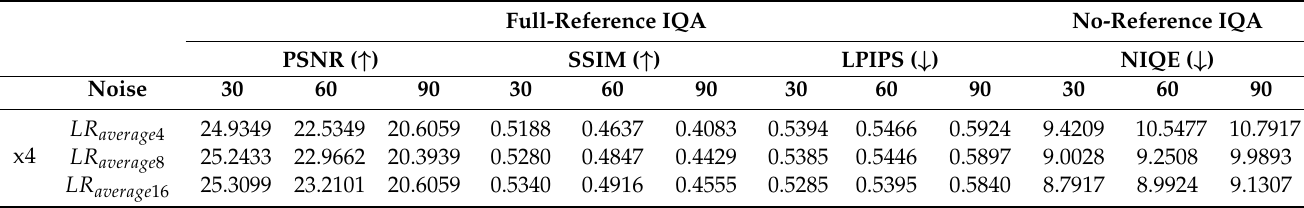
Table 1. Quantitative comparison of the proposed scheme on SwinIR [26] model based on PSNR, SSIM, LPIPS, and NIQE evaluations. PSNR and SSIM: higher is better; LPIPS and NIQE: lower is